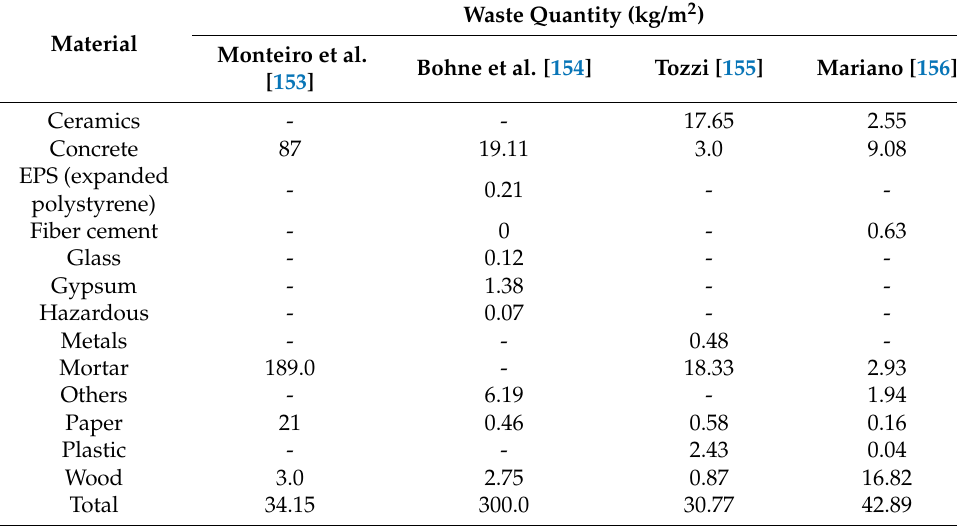
Table 6. The amount of building wastes generated during the construction